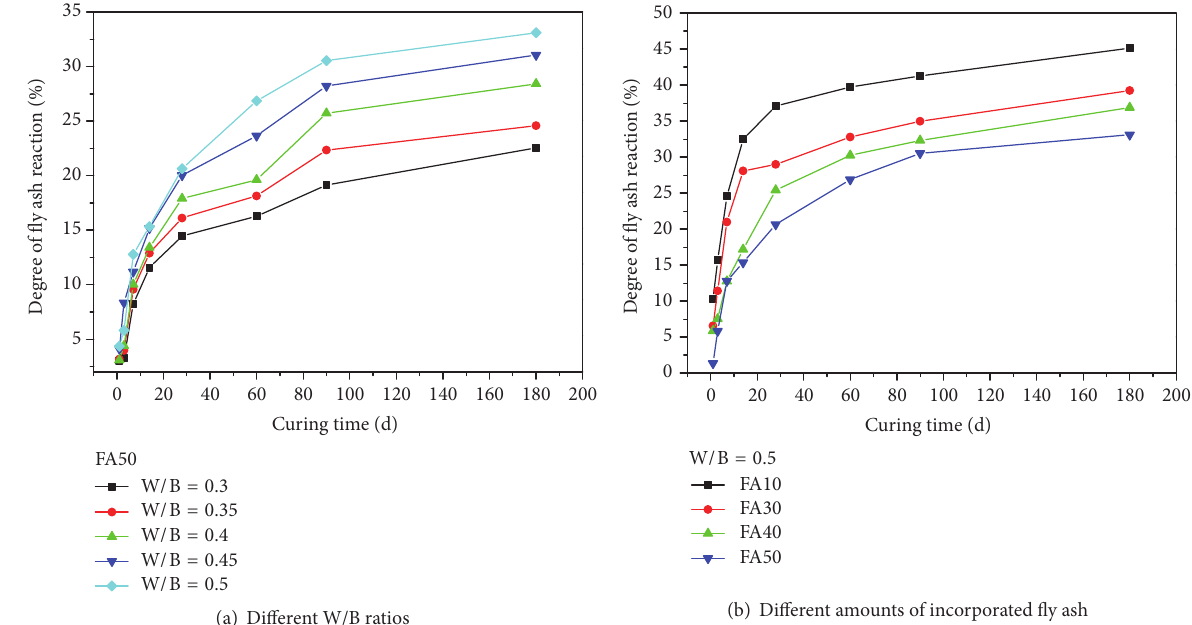
Figure 1: Effect of curing time on the degree of the fly ash reaction.